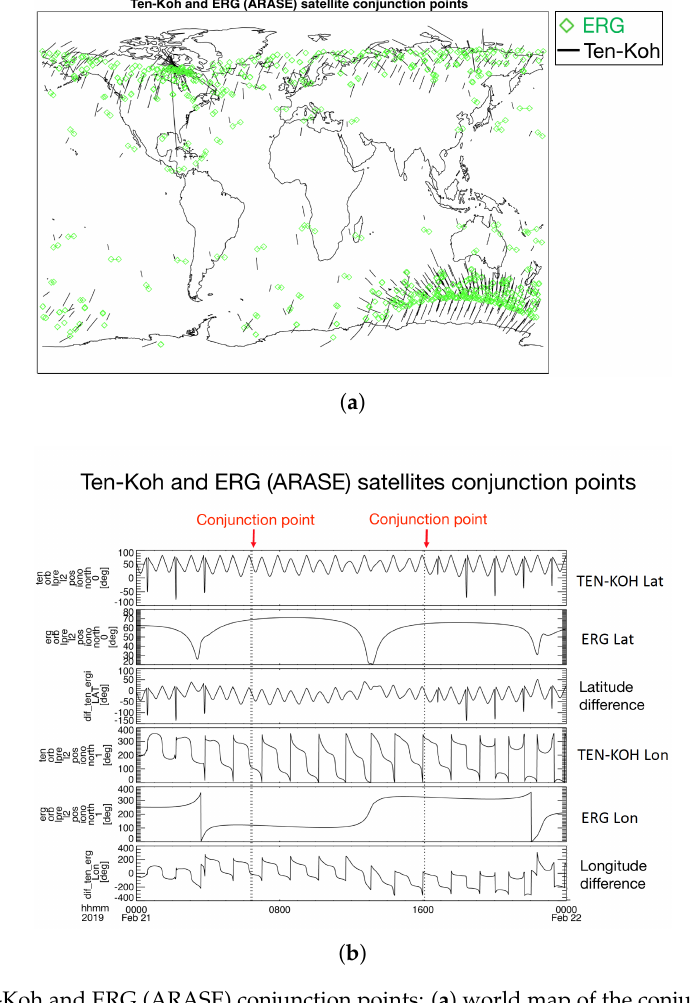
Figure 15. Ten-Koh and ERG (ARASE) conjunction points: ( a ) world map of the conjunction points for the period between 4 to 30 December 2019, showing both satellites footprints; and ( b ) example of two conjunction points computed for the period between 21 February 2019 and 22 February